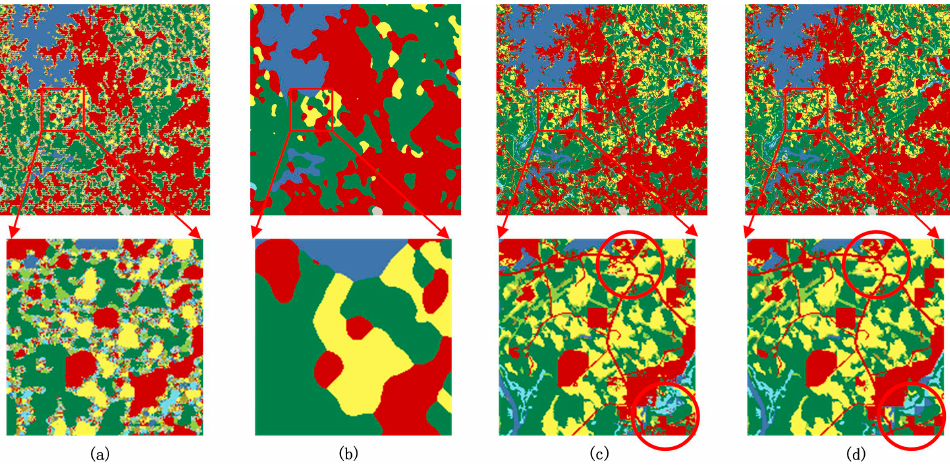
Figure 9. Resultant land cover maps generated by FCM_STSRM with different weighting coefficients: ( a ) α = 0.001, β = 0; ( b ) α = 10, β = 0.1; ( c ) α = 0, β = 0.01; and ( d ) α = 0.01, β =